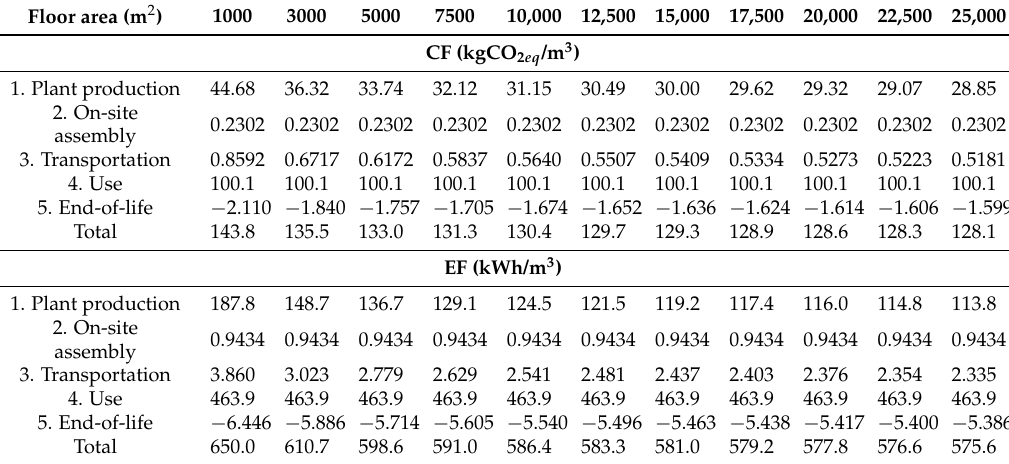
Table 5. Carbon and energy footprint results for the reference scenario.